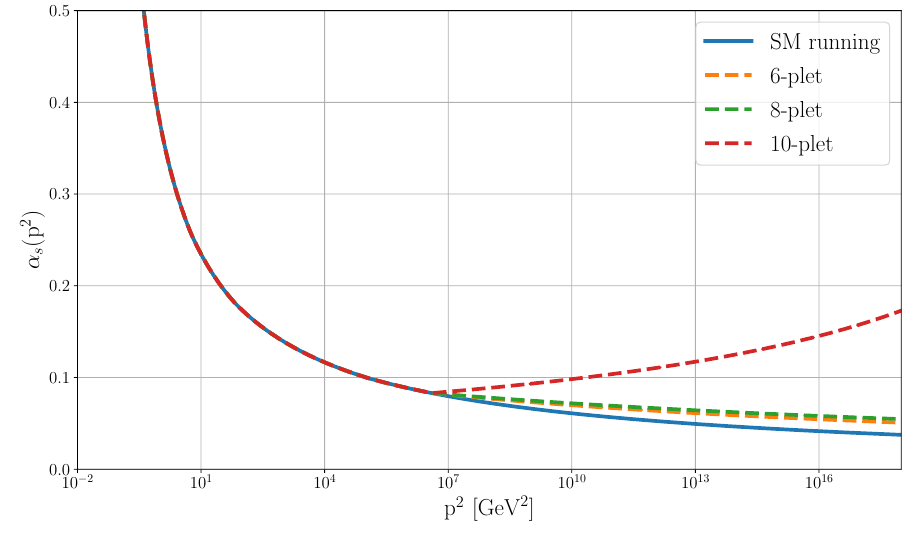
( p 2 ) for the SM particle content s C